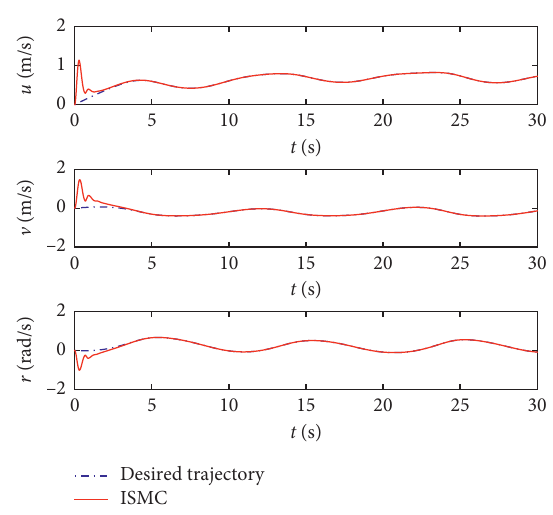
Figure 3: Velocity tracking on